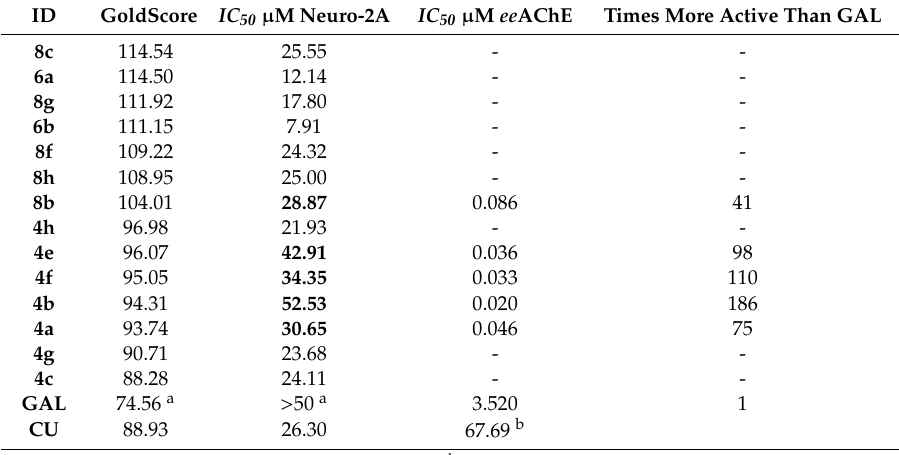
Table 1. GoldScore, neurotoxicity and a ffi nity to AChE of the GAL-CU hybrids. The IC 50 values of the hybrids, less toxic than CU, are given in bold. The binding a ffi nity to AChE was measured only for the less toxic